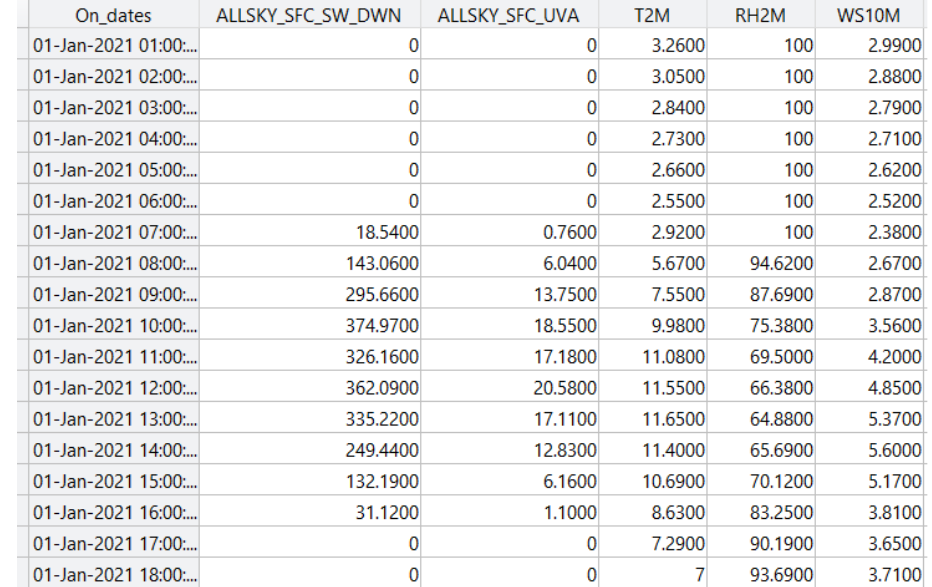
Figure 4. Screenshot of the hourly weather dataset, downloaded from [24].